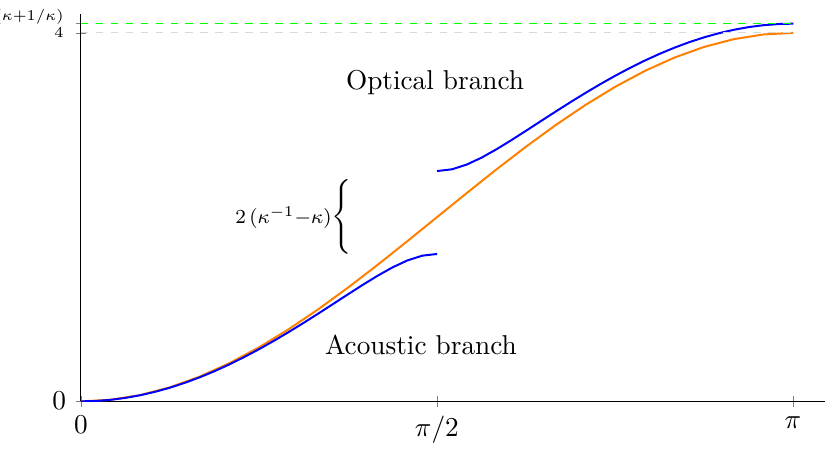
Figure 10 . A plot of the 1-magnon energy E 1 (blue line) for κ < 1 , as compared to the XXX energy E XXX = 2(1 − cos p ) at κ = 1 . The gap between the branches is 2(1 /κ − κ ) , and the 1 maximum of the energy is 2( κ + κ − 1 )